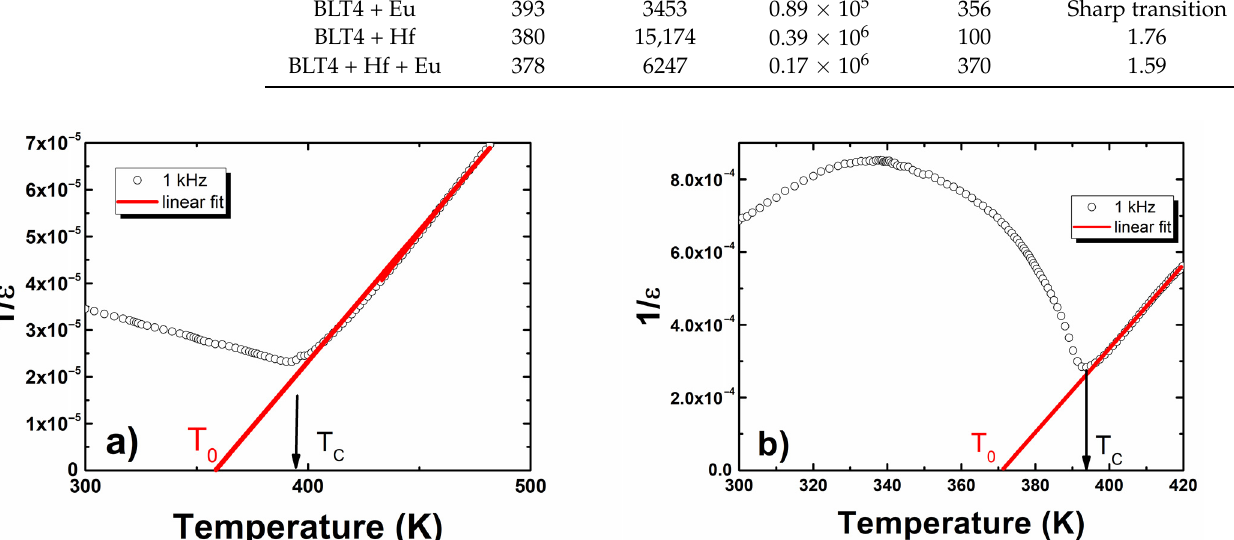
Figure 4. The reciprocal permittivity at 1 kHz as a function of temperature for ( a ) BLT4 and ( b ) BLT4 + Eu ceramics.